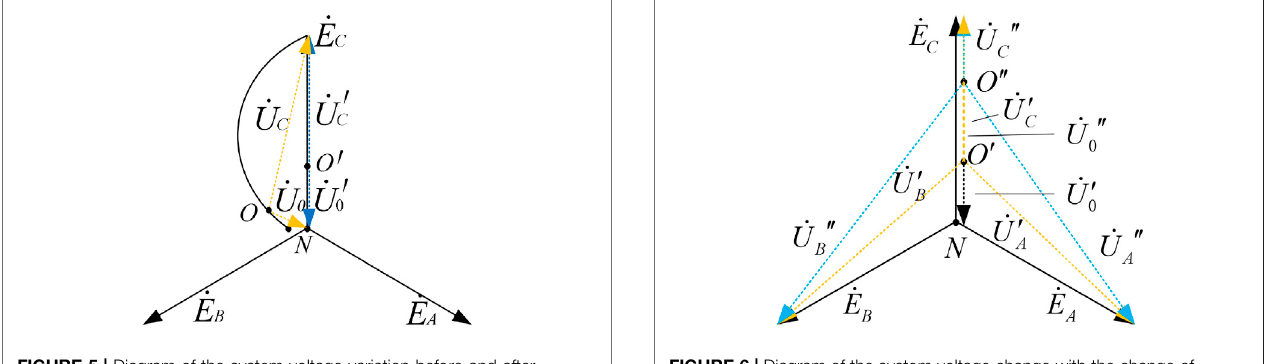
FIGURE 6 | Diagram of the system voltage change with the change of the grounding tap of the transformer.